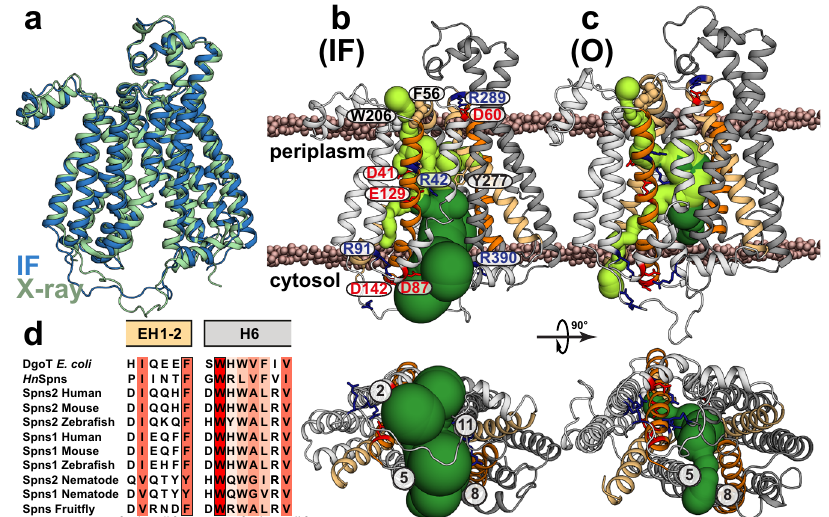
Fig. 9 | Sampled conformational states of Hn Spns reveal a noncanonical, ligand-dependent alternating access in the absence of an obvious outward- facing state. a The re fi ned X-ray structureof Hn Spns in the lipid membrane based on the pH 9 DEER distance populations in nanodiscs (Supplementary Fig. 15), is IF and comparable to the IF X-ray structure. b Calculated tunnels using software MOLEonline 2.5 within the IF model (dark green) indicate that the substrate can reachthebindingsiteeitherfromtheinnerlea fl etofthemembranethroughTMs2/ 11 and 5/8 gates or directly from the cytoplasm. Thus, both lipophilic and water- solublesubstratescangetaccesstothetransporter.Inthisconformation,Arg42 TM1